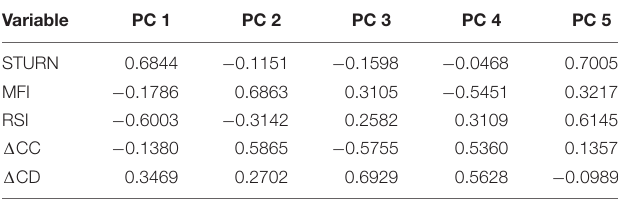
TABLE 5 | The eigen vector loadings